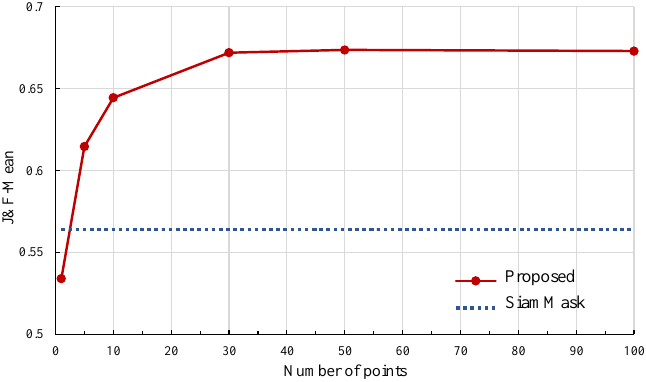
Figure 7. The mean J & F performances on DAVIS2017 according to the number of point clicks [19].